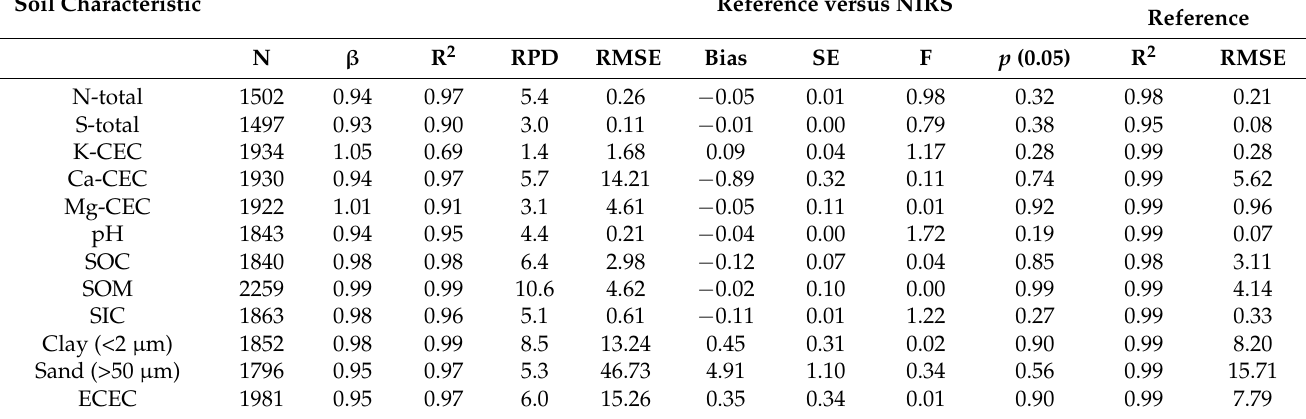
Table 4. Soil characteristics, number of samples (n), slope ( β ), determination coefficient (R 2 ), RPD, root mean squared error (RMSE) of the average difference between NIRS and reference (bias), standard error of bias (SE bias), F- and p -values (ANOVA) of the reference versus NIRS, and R 2 and RMSE of the reference versus the reference (duplicate) for the validation data